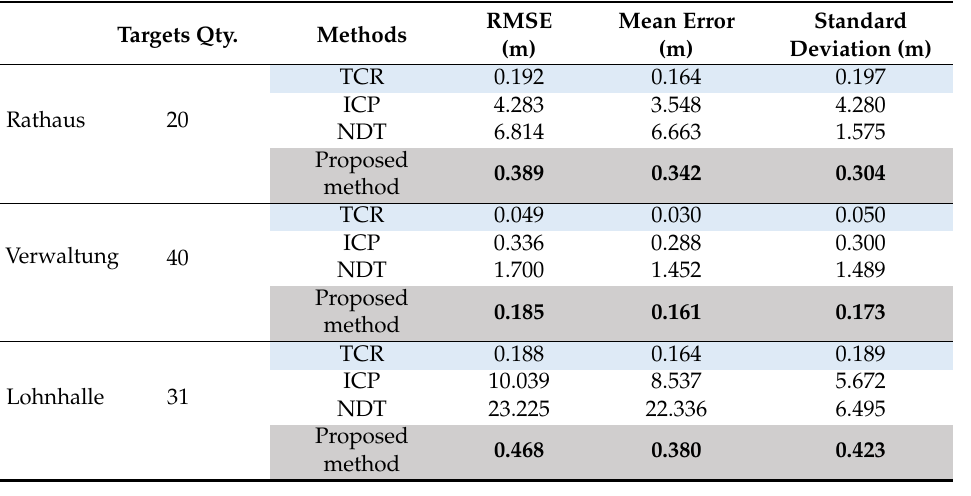
Table 2. The root mean square error (RMSE), the mean error (ME), and the standard deviation (SD) of the proposed method compared with target center registration (TCR), ICP and